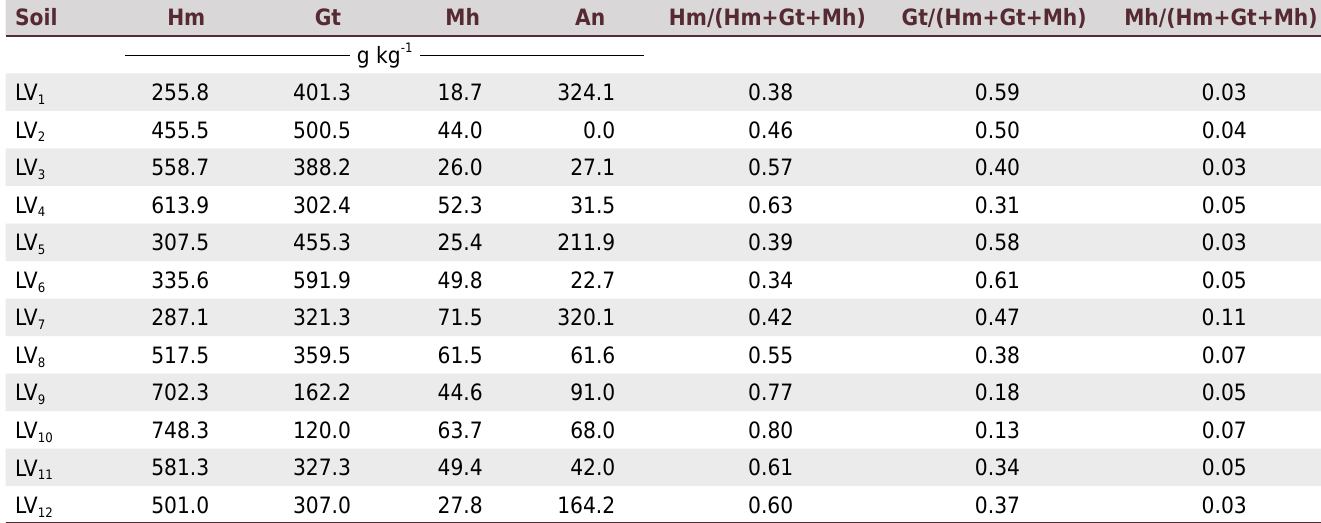
Table 1. Estimated mineralogical composition of the clay fraction after treatment with NaOH 5 mol L -1 by Rietveld refinement